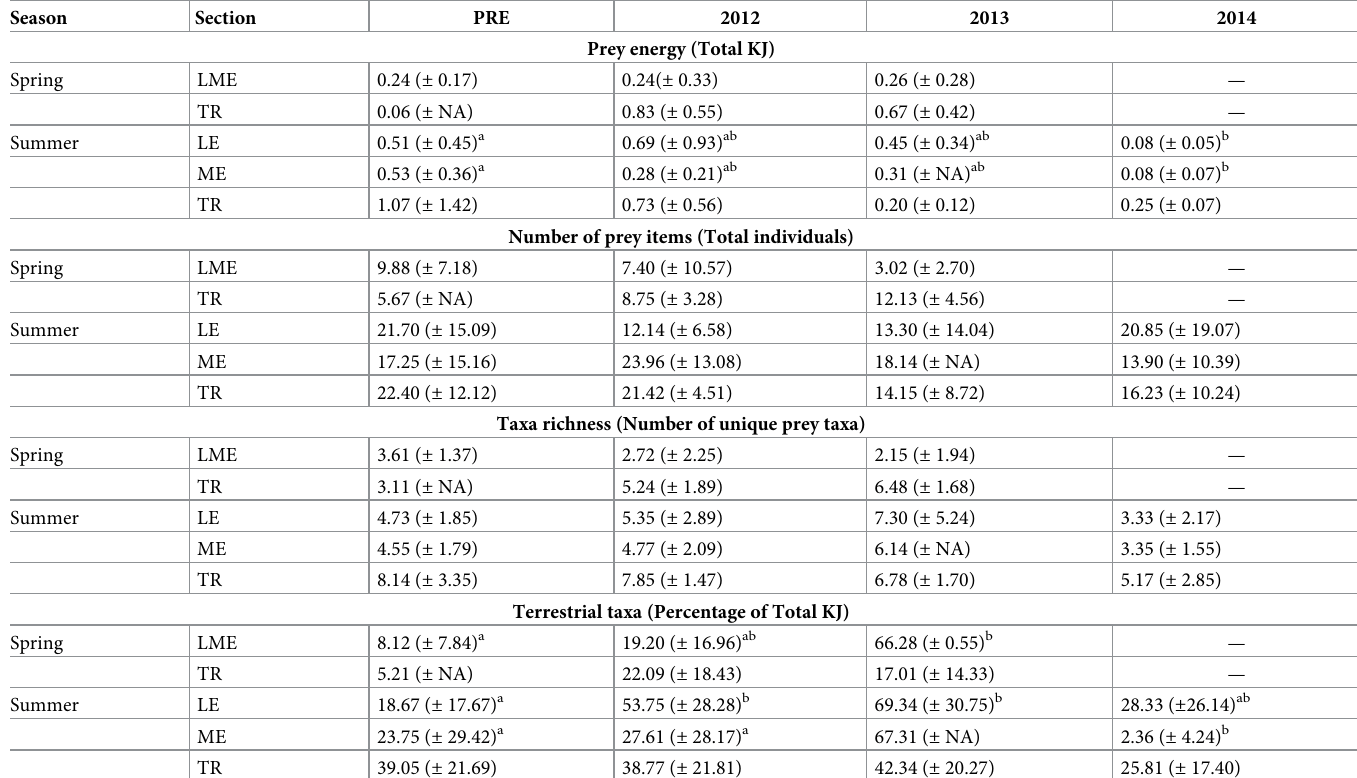
Table 8. Univariate diet metrics (means ± 1 SD) for trout collected in the river. Season